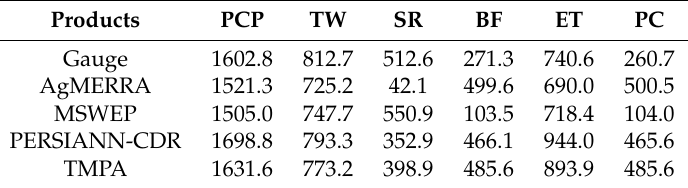
Figure 6. Parameter distributions of six more sensitive hydrological parameters for the four precipitation products: red points represent the best-suited parameter. Table 7. Optimal simulation value of the main hydrological cycle variables over the calibration and validation period (from 2000 to 2007, Unit: